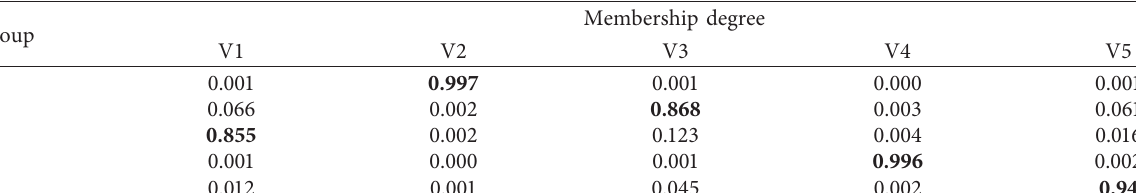
Table 8: The membership degree of five types of